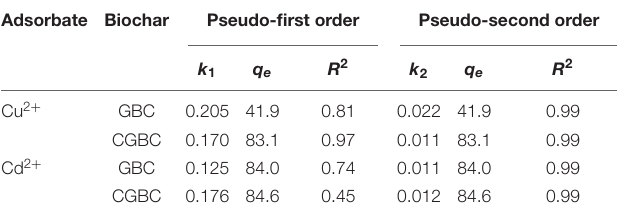
TABLE 3 | Pseudo-first and second order parameters for Cu 2 + and Cd 2 + adsorption of at pH of 5 and 100 ppm of metal adsorbate using GBC and CGBC. Adsorbate